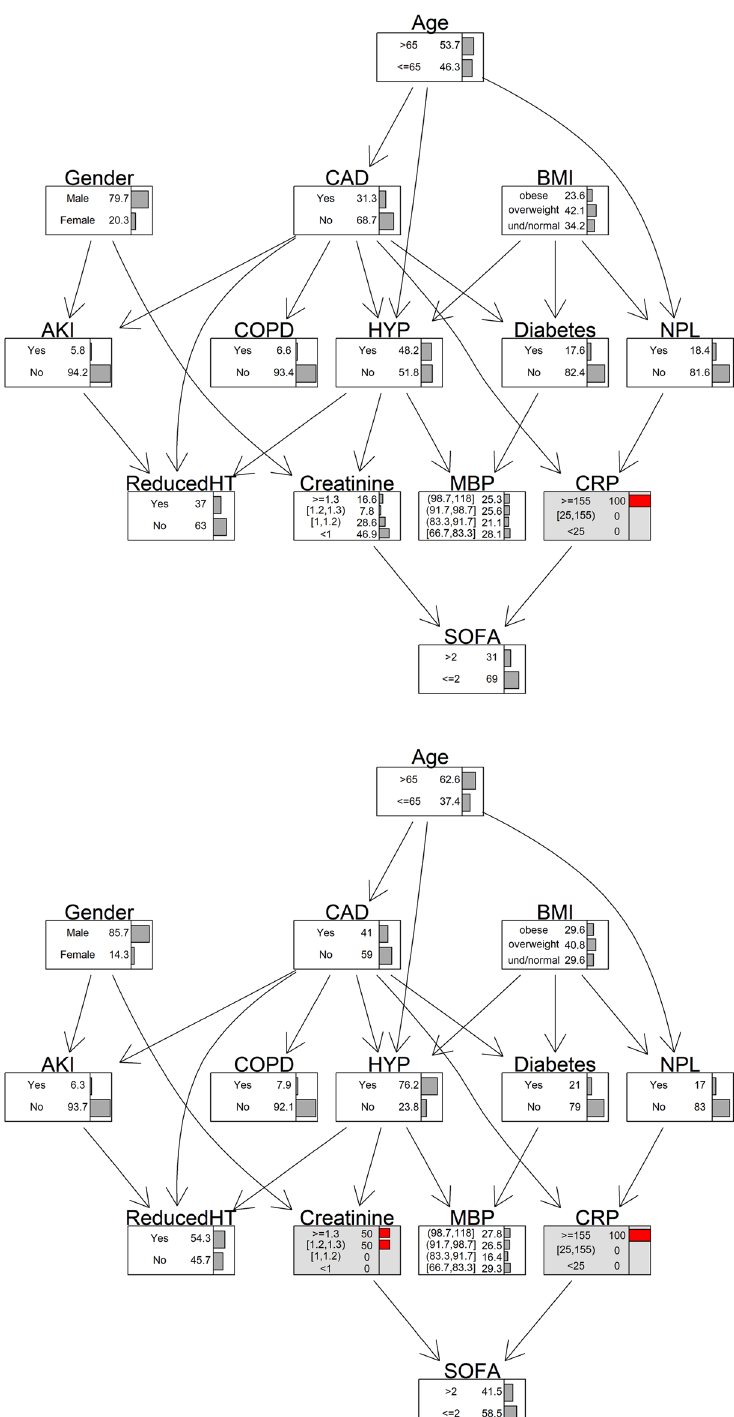
Figure 4. Hypothetical scenarios. Conditioned on CRP ≥ 155 mg/L and conditioned on CRP ≥ 155 mg/L and creatinine ≥ 1.2